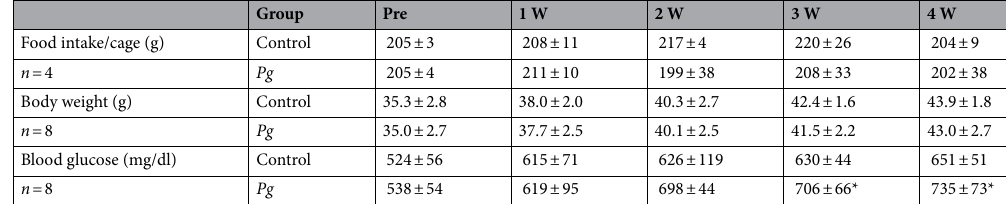
Table 1. Food intake, body weight and blood glucose at ad libitum feeding in Porphyromonas gingivalis ( Pg )- and carboxymethyl cellulose control-treated db / db mice fed ad libitum, at baseline and 1–4 weeks after treatment. Data are expressed as mean ± standard error of mean. Blood glucose levels were measured at ad libitum feeding. * P < 0.05 as compared with that of the control.